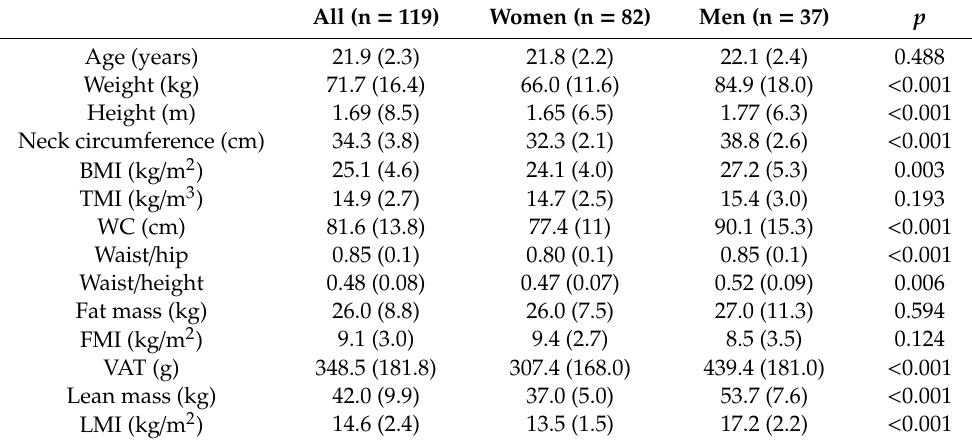
Table 1. Characteristics of the participants.